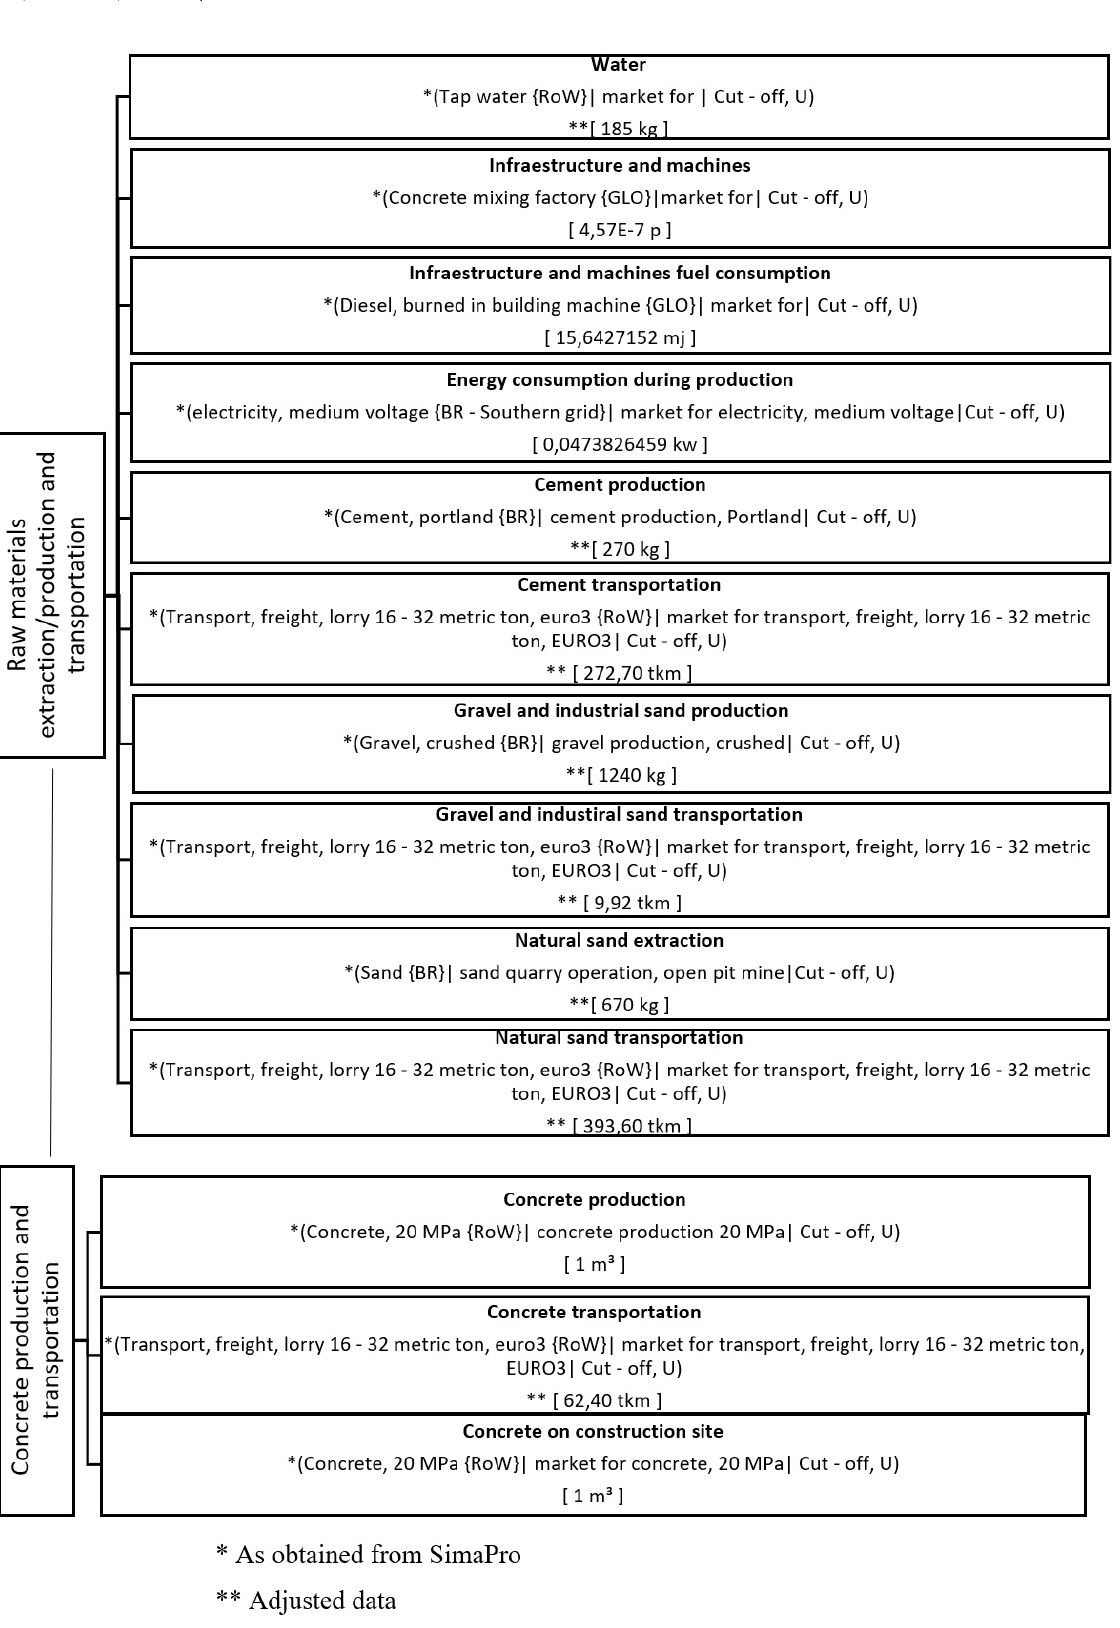
Figure 3. Flowchart with adjusted data for 20 MPa